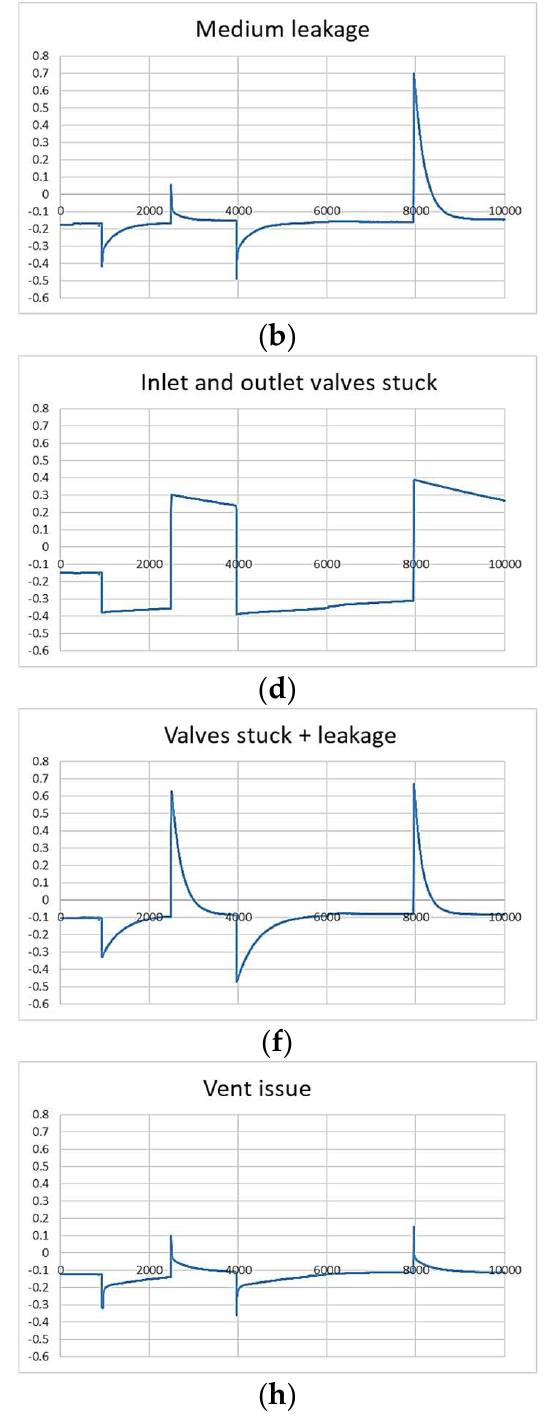
Figure 11. Pressure profiles of micropumps that fail during the functional dry test in production. The vertical axis is the relative pressure in the pumping chamber in bar, while the horizontal axis is the time in milliseconds. A non-exhaustive list of failure modes is shown here: ( a ) large leakage; ( b ) medium leakage; ( c ) inlet valve stuck; ( d ) inlet valve stuck and leakage; ( e ) outlet valve stuck; ( f ) inlet and outlet valves stuck and leakage; ( g ) leakage and inverted piezo poling that induces a positive peak of pressure at t = 1 s; ( h ) vent issue that does not allow the pneumatic control of the outlet valve during the dry test.